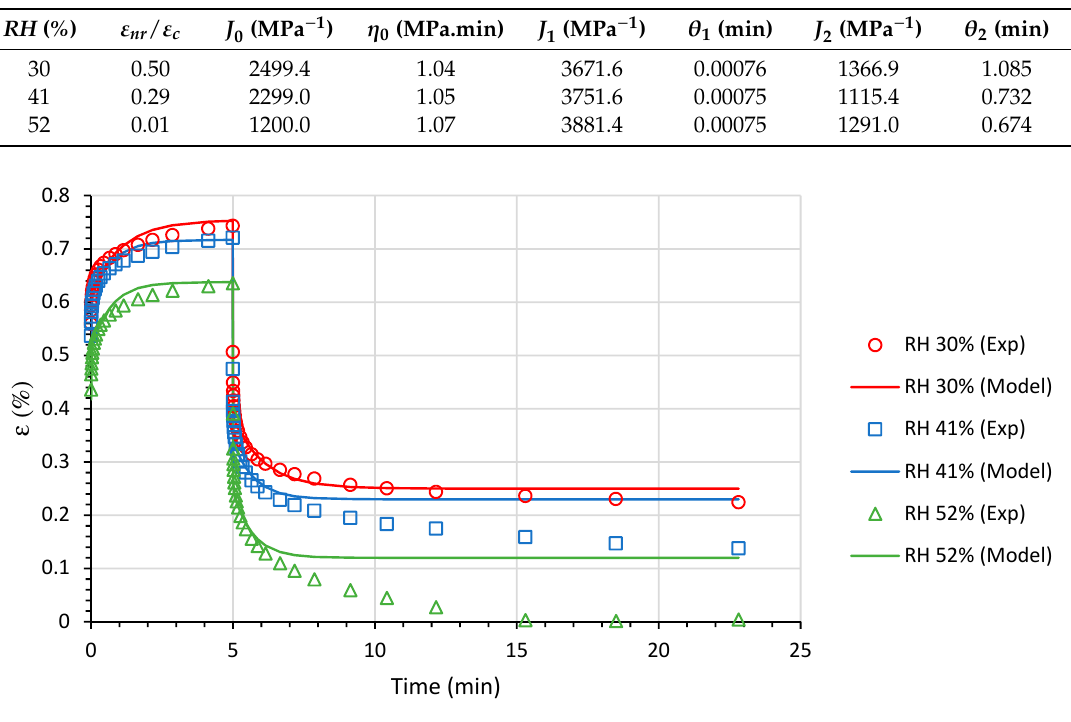
Figure 15. Creep-recovery curves of starch-beet pulp foams at different RH conditions.